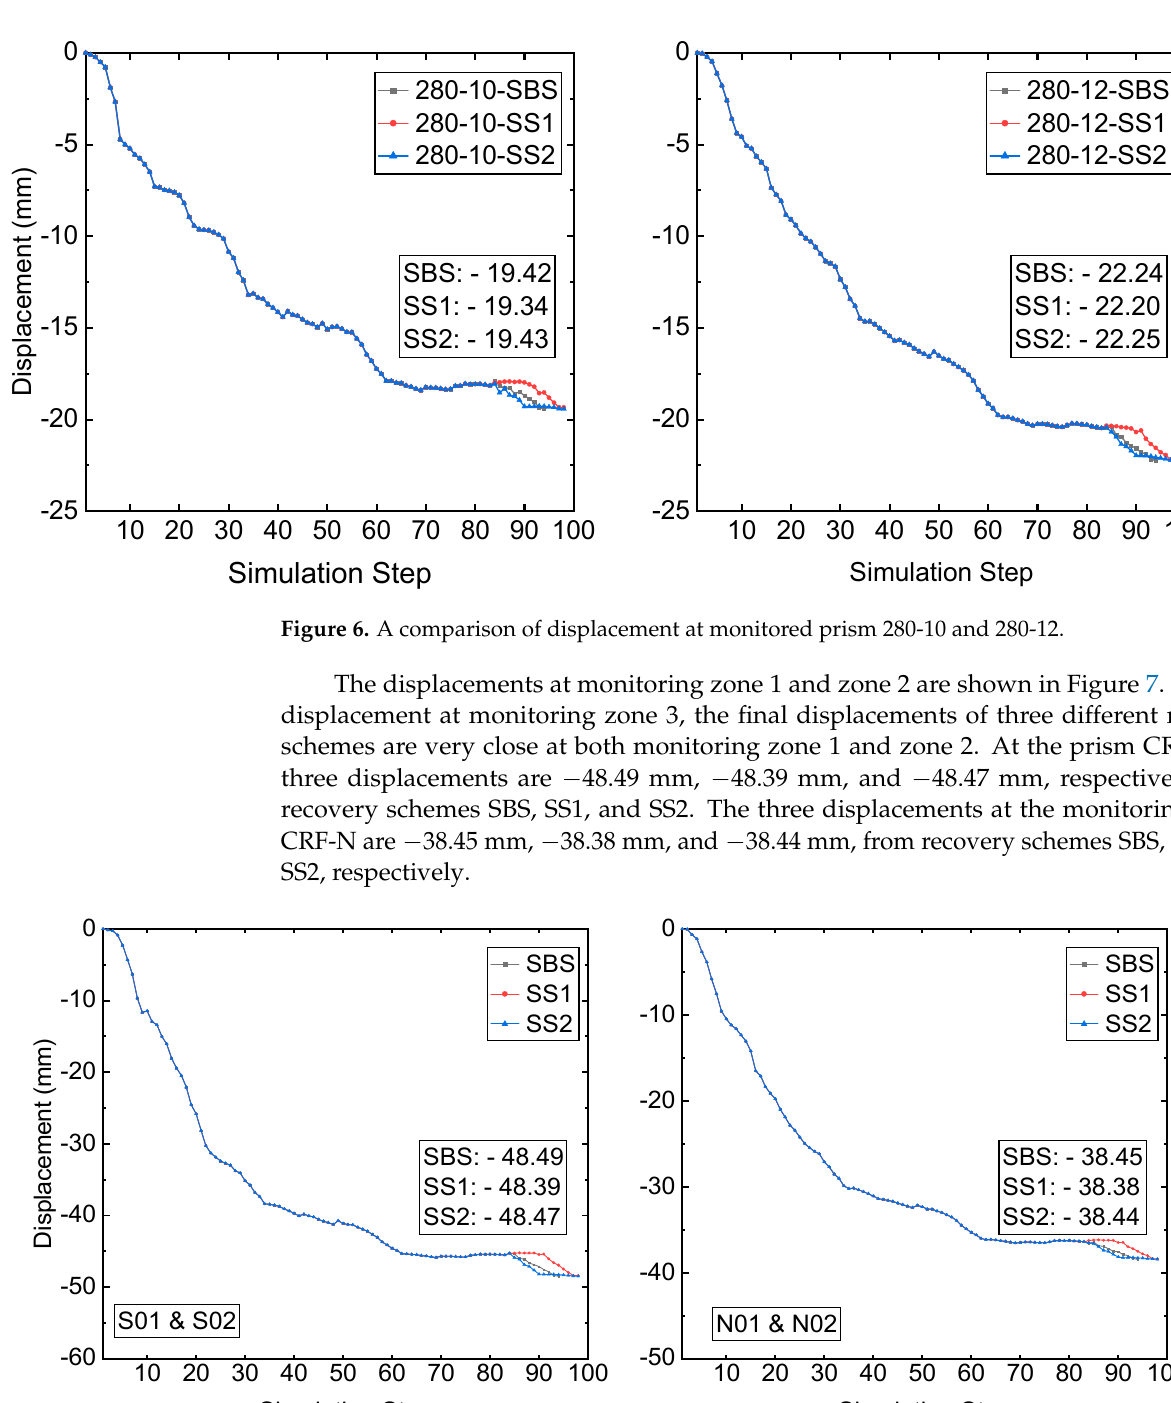
Table 3. Sill pillar recovery induced displacement at monitoring zones.